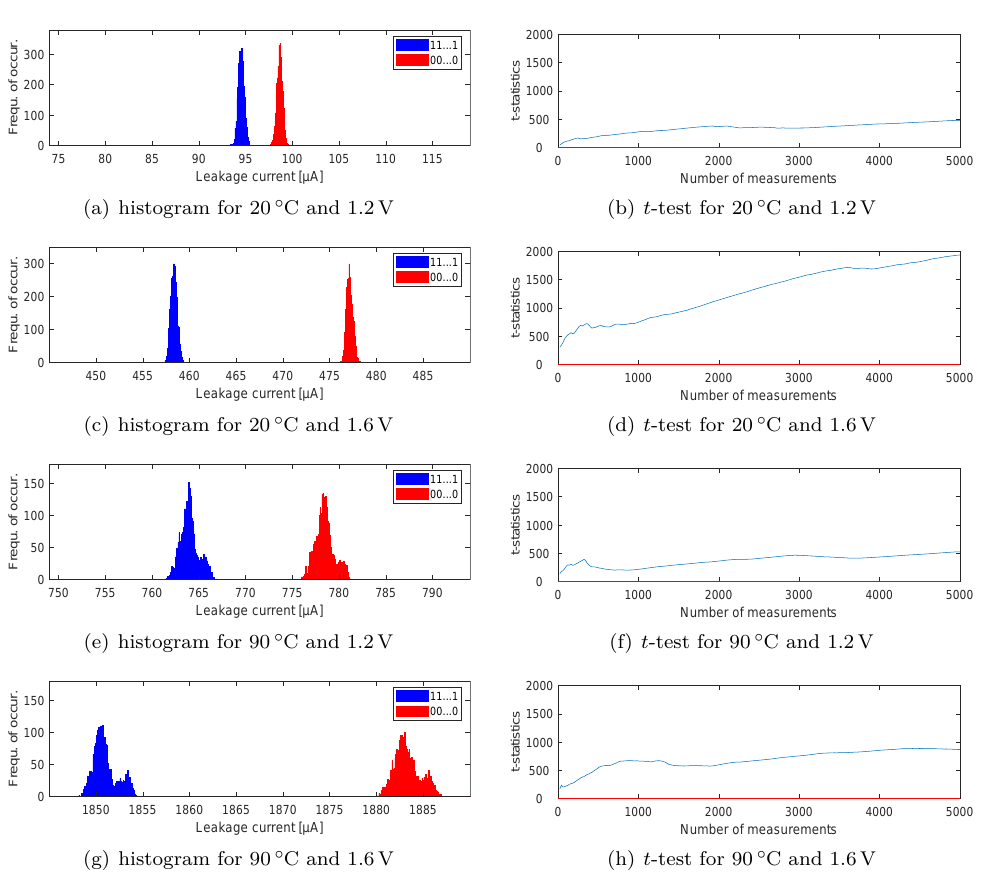
Figure 3: Histograms and t -test results for 5,000 static power measurements of a 1024-bit high-fanout register in 90 nm CMOS technology, filled either with only 1s or only